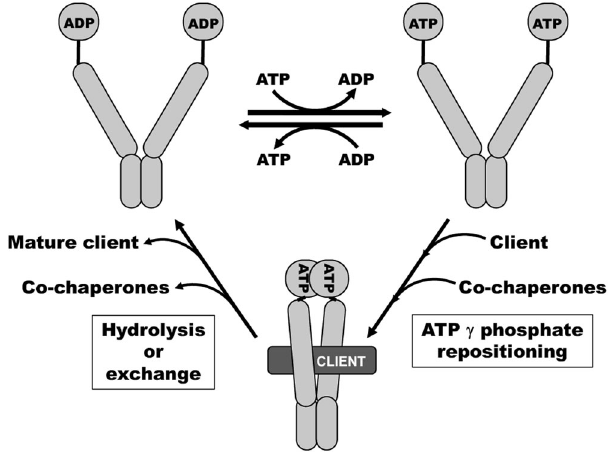
Fig. 7 | An exchange model of Hsp90 activity. Due to cellular nucleotide con- centrations and its higher af fi nity for ADP, Hsp90 likely populates the open, ADP- boundconformationafterhydrolysis(topleft).EquilibriumbetweenopenADPand ATP states, including ADP/ATP heterodimers (not depicted) is established due to the cellular ATP:ADP environment and regulation by co-chaperones. In the open ATP conformation, Hsp90 is primed for client binding (top right). Binding of the client, co-chaperones and, we propose, the proper positioning of the gamma phosphate of ATP drives formation of the closed clamp (bottom). Hydrolysis or exchangereturnsHsp90totheADPstate(topleft),releasingthematureclientand co-chaperones.ThereturntotheADPstatefromtheclosed-clampisessential,since cells expressing a mutant Hsp90 that could not hydrolyze ATP or bind ADP effectively were barely